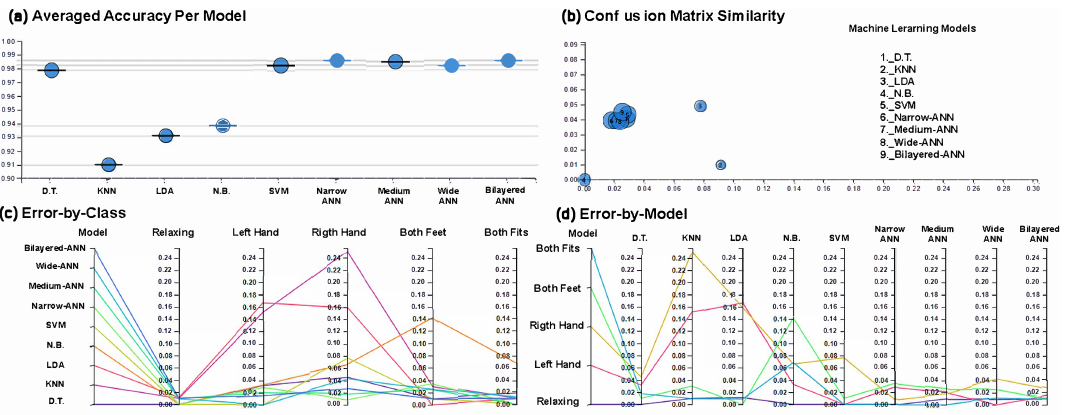
Figure 8. ConfusionVis [56]: Comparative evaluation of the multiclass classifiers based on confusion matrices. ( a ) Averaged accuracy per model, ( b ) confusion matrix similarity, ( c ) error by class, and ( d ) error by